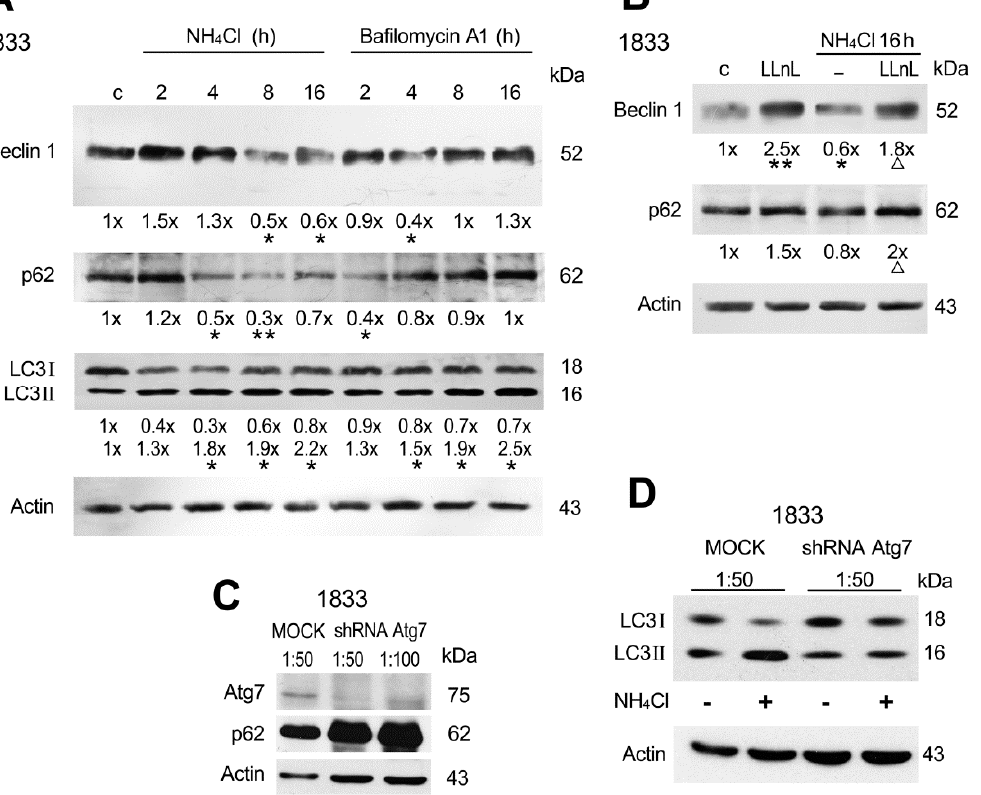
Figure 3. Markers of autophagy in 1833 cells, and effect of Atg7 knock down. ( A ) Samples of total protein extracts (100 µg) were analysed by Western blot. Actin was used for normalization. The experiments were repeated three times with similar results. * p < 0.05; ** p < 0.005 versus control; ( B ) Samples of total protein extracts (100 µg) from cells pre-treated with the proteasome inhibitor LLnL were analysed by Western blot. Actin was used for normalization. The experiments were repeated three times with similar results * p < 0.05; ** p < 0.005 versus control; Δ p < 0.05 versus 16-h NH 4 Cl treated cells; ( C ) Samples of total protein extracts (100 µg) were analysed by Western blot. Two dilutions of shRNA Atg7 were tested. Actin was used for normalization. The experiments were repeated three times with similar results; ( D ) Samples of total protein extracts (100 µg) were analysed by Western blot. Actin was used for normalization. The experiments were repeated three times with similar results.